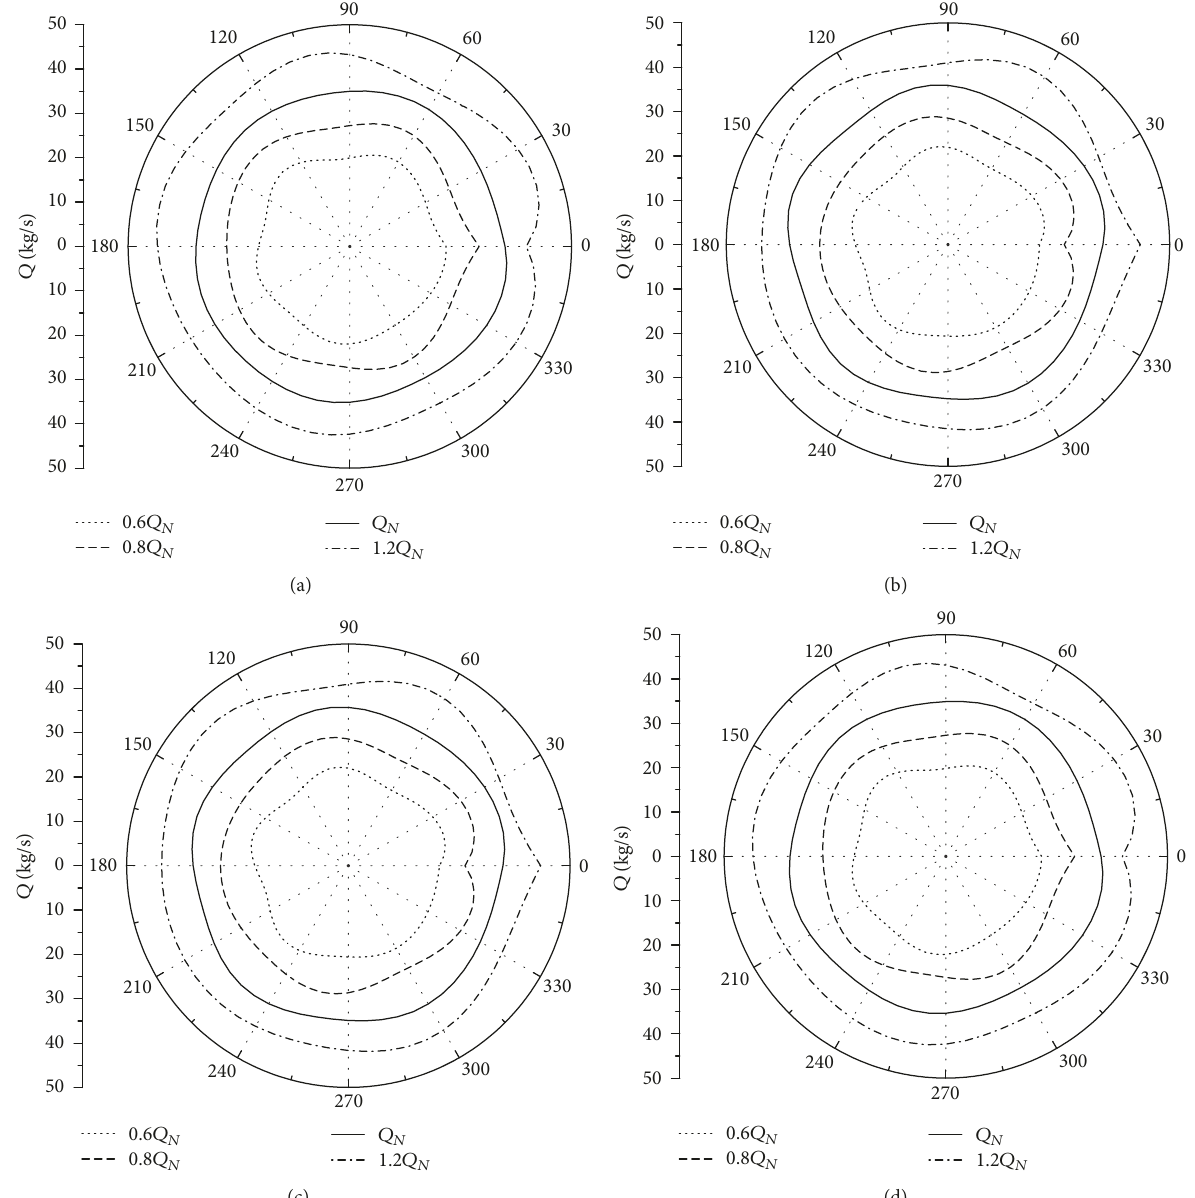
Figure 11: Flow pulsation of guide vanes. (a) T 0 , (b) T 0 +0.25 T , (c) T 0 +0.5 T , and (d) T 0 +0.75 T